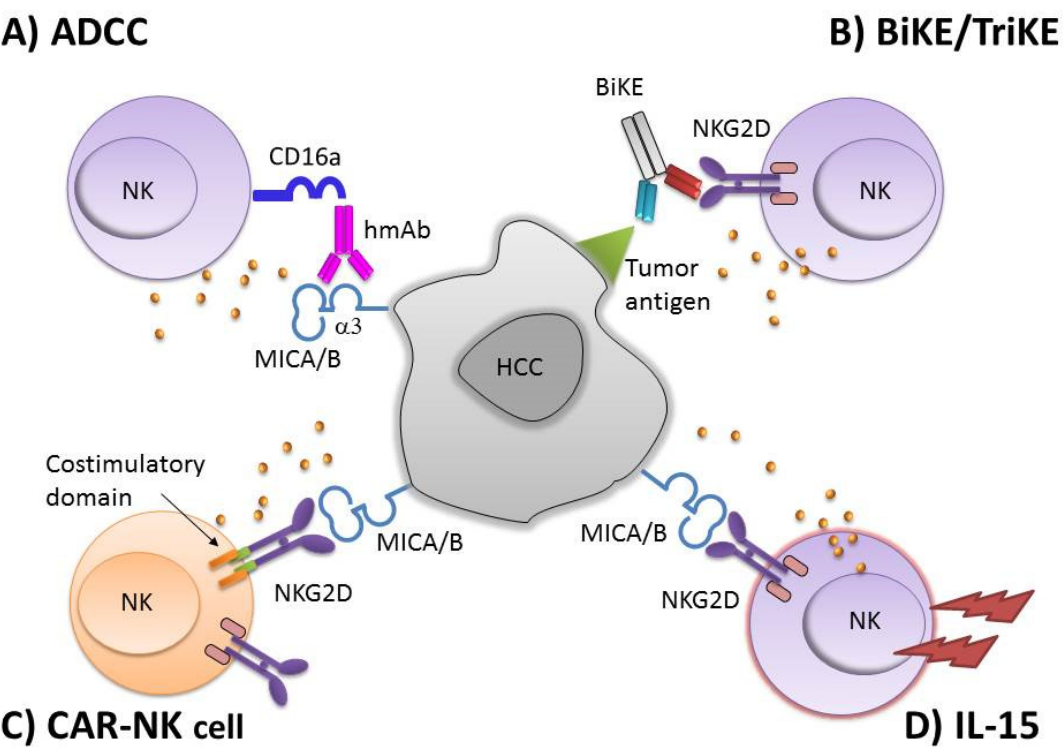
Figure 2. Possible NKG2D-MICA / B-based immunotherapy approaches. Di ff erent strategies can be used to induce NK cell activation to improve HCC killing. ( A ) MICA / B α 3 domain–specific mAb is able to induce NK cell-mediated antibody-dependent cytotoxicity (ADCC). ( B ) Bi-specific or tri-specific killer engagers (BiKE or TriKE), capable of binding NKG2D expressed on NK cells and one tumor antigen on HCC can maximize targeting of tumor cells. ( C ) A chimeric antigen receptor containing the NKG2D extracellular domain that binds to MICA / B ligands, fused to a spacer and trans-membrane domain. The intracellular domain contains costimulatory domains, such as CD28 and 4-1BB and the CD3 ζ chain, which drive signal activation and amplification of CAR-NK cells. ( D ) cytokines, such as interleukin (IL)-15, can also be employed to generate cytokine induced NK cells.